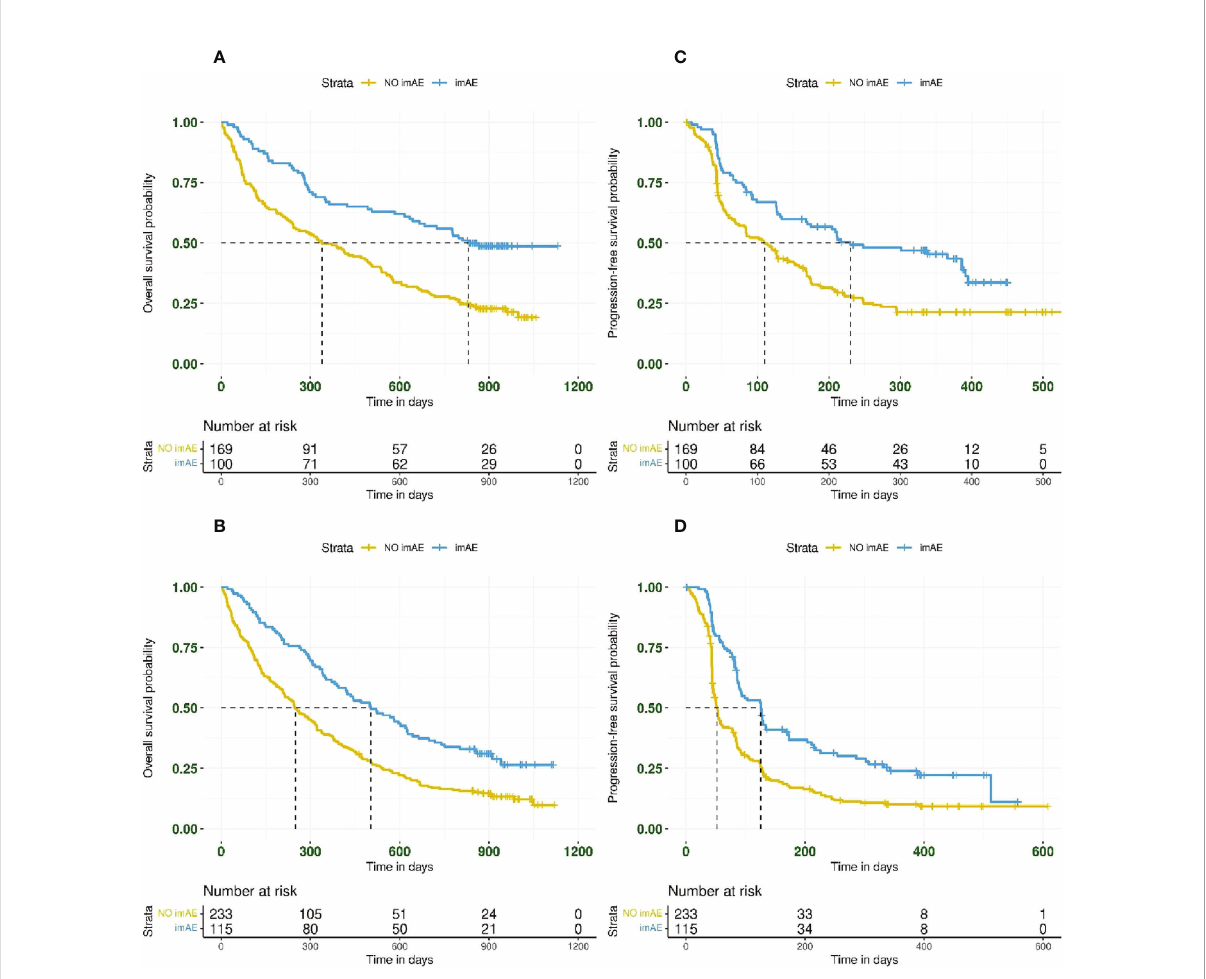
FIGURE 3 Kaplan – Meier plots for overall survival and progression-free survival based on imAE development in patients with PD-L1 TC ≥ 25% (panels A , C for OS and PFS, respectively) and in patients with PD-L1 TC <25% (panels B , D for OS and PFS, respectively). Data from patients randomized to durvalumab (n = 307) were combined with those from patients randomized to durvalumab plus tremelimumab (n = 310) before analyzing by PD-L1 subgroup. imAE, immune-mediated adverse event; OS, overall survival; PD-L1, programmed cell death ligand-1; PFS, progression-free survival; TC, tumor